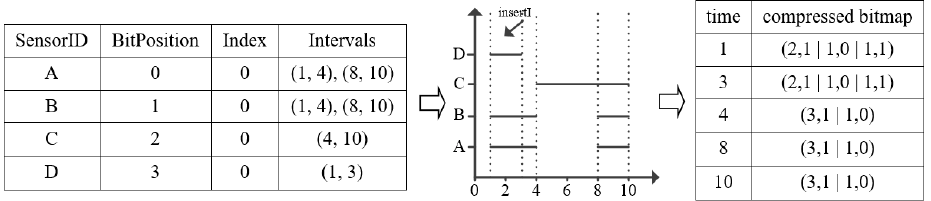
Figure 4. Interval Insertion Example.